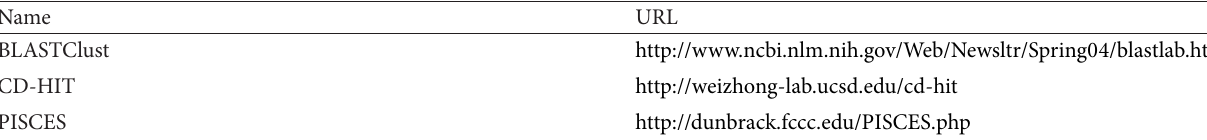
Table 2: List of three